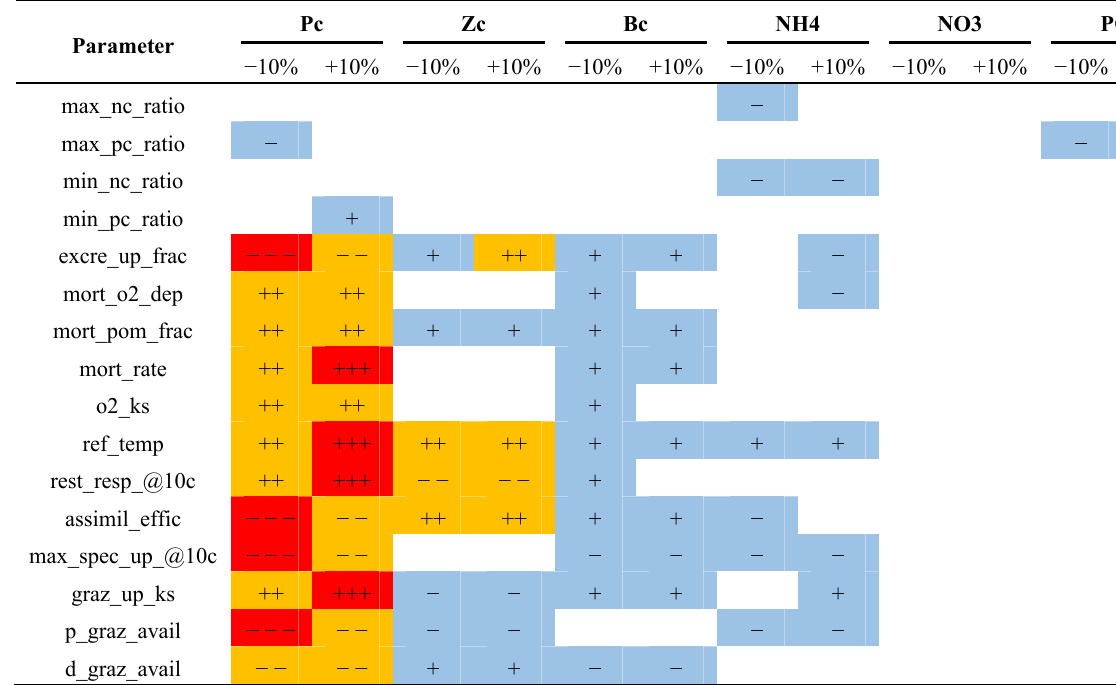
Table 11. SA result matrix for consumers’ parameters impact on the analyzed variables. Color code: blue for sensitive ( S > 0.1), orange for highly sensitive ( S > 1) and red for extremely sensitive ( S > 10). The signs + and − stand for positive and negative perturbation, respectively. A description of the variables and parameters is found in Tables 1 and 3,